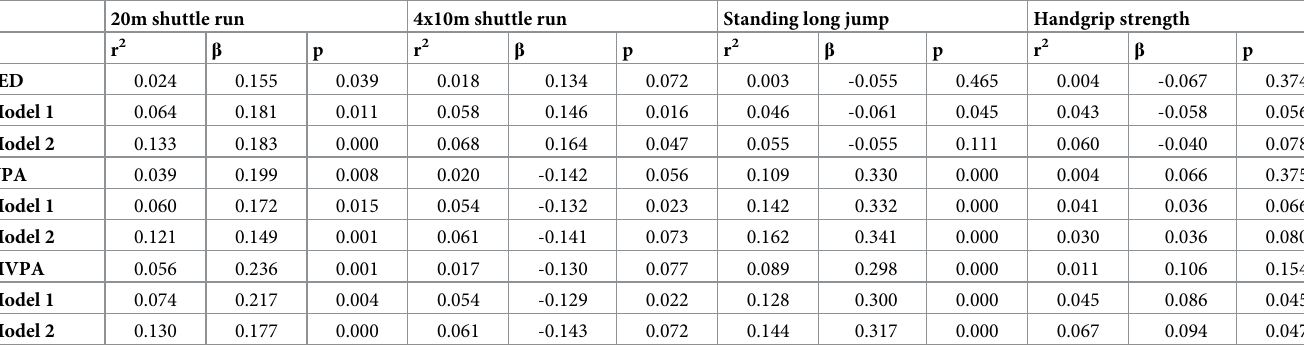
Table 4. Associations of physical fitness with sedentary time and different PA